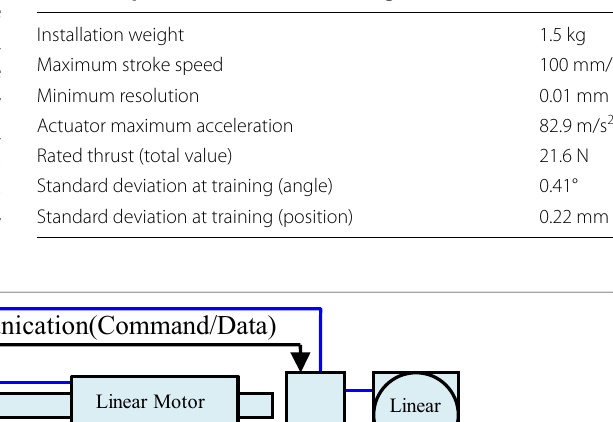
Table 2 Specification of the training